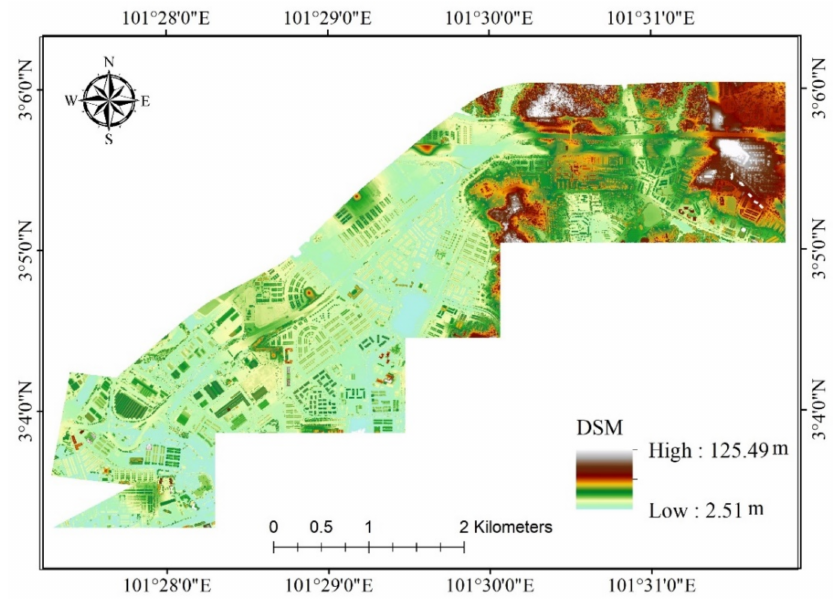
Figure 2. Digital surface raster (DSM) layer. Table 1. Summary statistics of noise